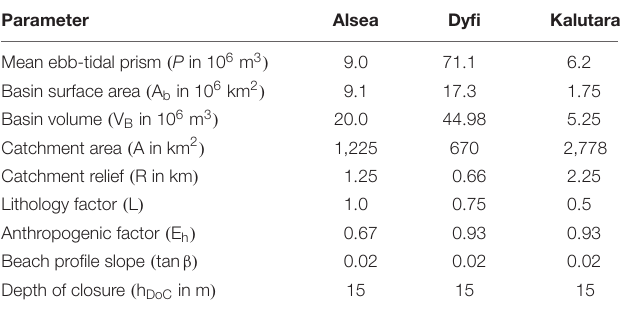
TABLE 1 | Properties of the selected barrier estuary systems (reference